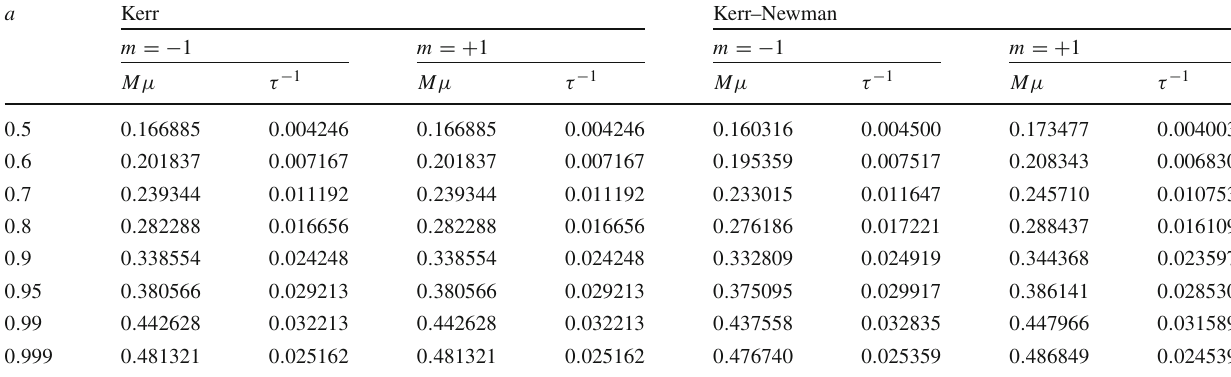
Fig. 3 Massive scalar resonant frequencies in the Kerr–Newman black hole spacetime for m = − 1, a = 0 . 99, e = 1, and Q = 0 . 01. The left plots ( j ) /μ ] , while the right plots show the decay (or growth) rate Im [ ω ( j ) show the oscillation frequency Re [ ω mN ( j ) /μ ] , in the Kerr and Kerr–Newman (with e = 1 and Q = 0 . 01) black holes. We focus Table 4 Maximum instability growth rates, τ − 1 ∼ Im [ ω mN on the N = 0 and m = − 1 , + 1